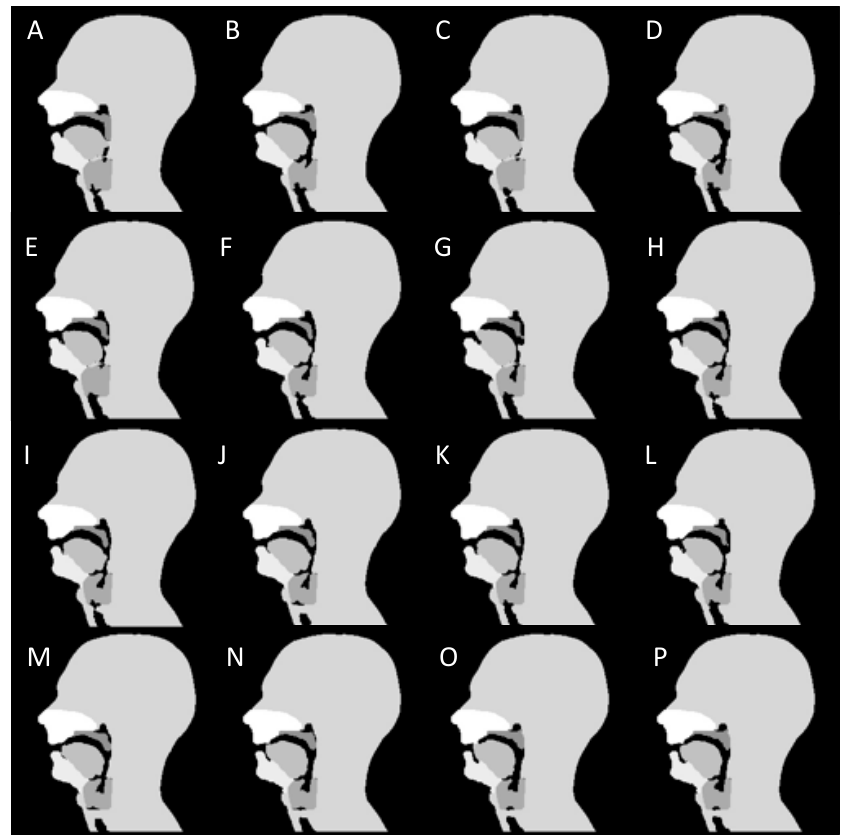
Figure 7. Sixteen successive frames ( A – P ) during the non-sense phonation “za-na-za”. The first 4 frames are during the end of the initial “za” and the soft palate is closed ( A – D ). The soft palate opens in the next frame at the beginning of the sound “na” ( E ) and recloses at the beginning of the next “za” ( M ) and remain closed thereafter (N – P ). During the sound “na” ( E – L ), forward movement of the tongue can also be seen.